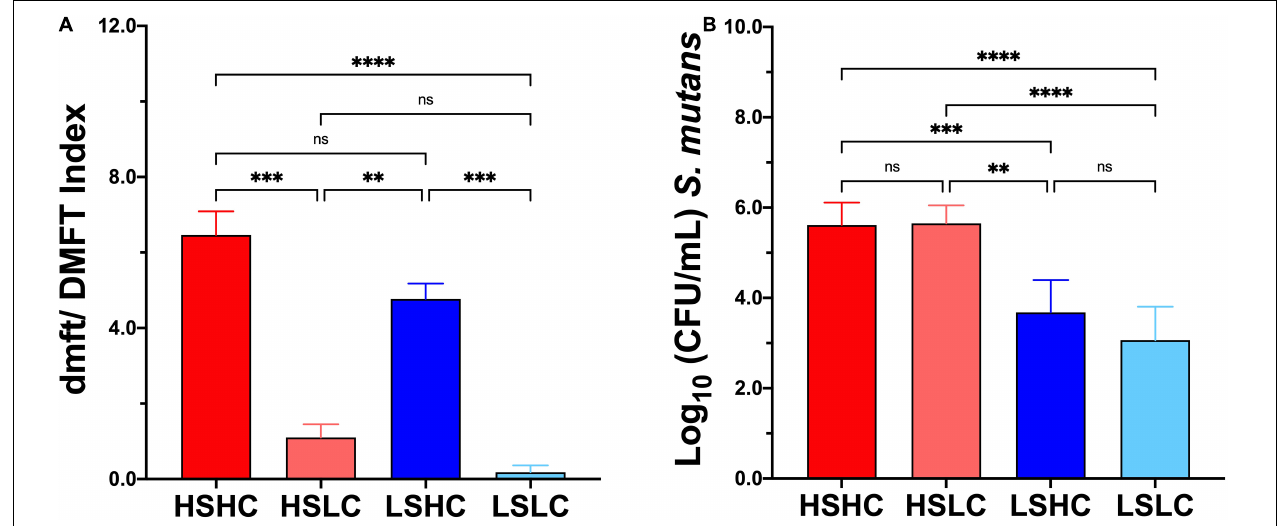
FIGURE 1 | Caries experience and salivary Streptococcus mutans levels quantification. (A) Caries status was assessed using decayed, missing, and filled tooth (dmft/DMFT) criteria, and the graphic represents the average caries experience. (B) S. mutans levels were evaluated by selective culture media method, and the graphic represents the mean of S. mutans Colony Forming Units (CFU/mL), per group (HSHC, HSLC, LSHC, and LSLC), and error bars represent the standard deviation (SD). Differences in significance between groups were analyzed using one-way ANOVA followed by Kruskal–Wallis multiple comparisons tests; ∗∗ p < 0.005, ∗∗∗ p < 0.0005, ∗∗∗∗ p < 0.00005.